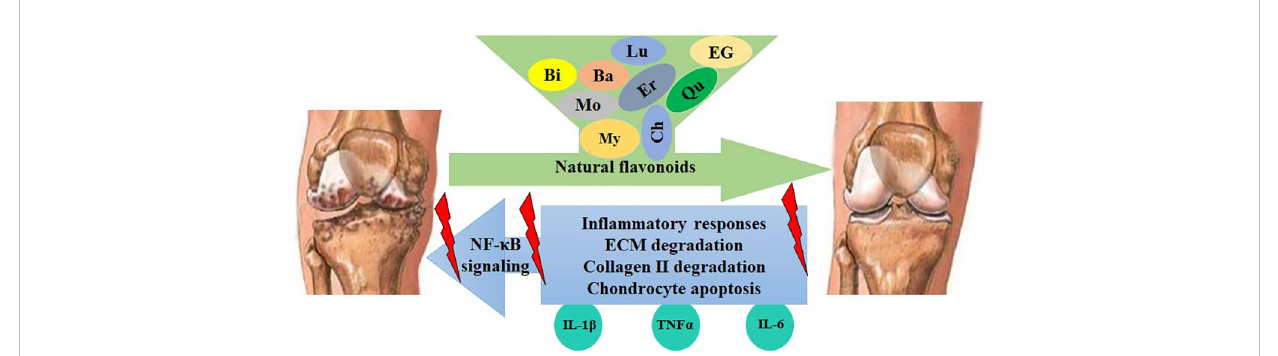
FIGURE 5 Flavonoids protect against OA development by inhibiting the NF- k B-mediated in fl ammatory responses. Activated NF- k B signaling increases the expression of IL-1 b , TNF a , COX-2, PGE2, iNOS, NO, MMPs, and ADAMTSs, leading to the enhancement of ECM degradation, collagen II degradation, and chondrocyte apoptosis. These catabolic responses can be blocked by fl avonoids, such as myricetin (My), quercetin (Qu), morin (Mo), baicalin (Ba), luteolin (Lu), chrysin (Ch), EGCG (EG), eriodictyol (Er), and biochanin A